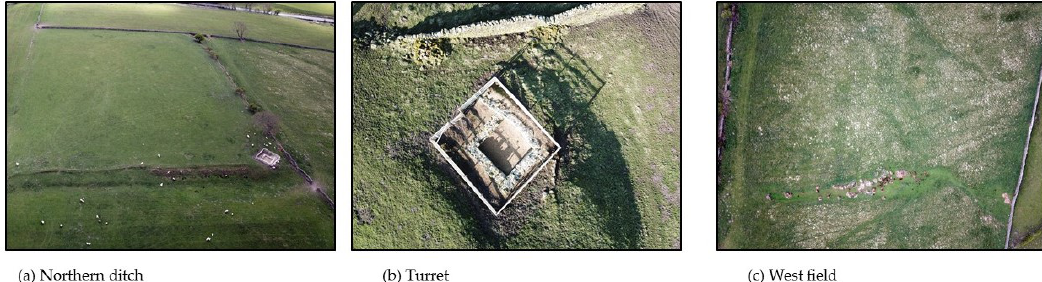
Figure 6. Aerial photography of Magna Fort showing visible evidence of soil erosion (courtesy of the Vindolanda Trust). The location and direction of each photograph is shown in Figure 2.